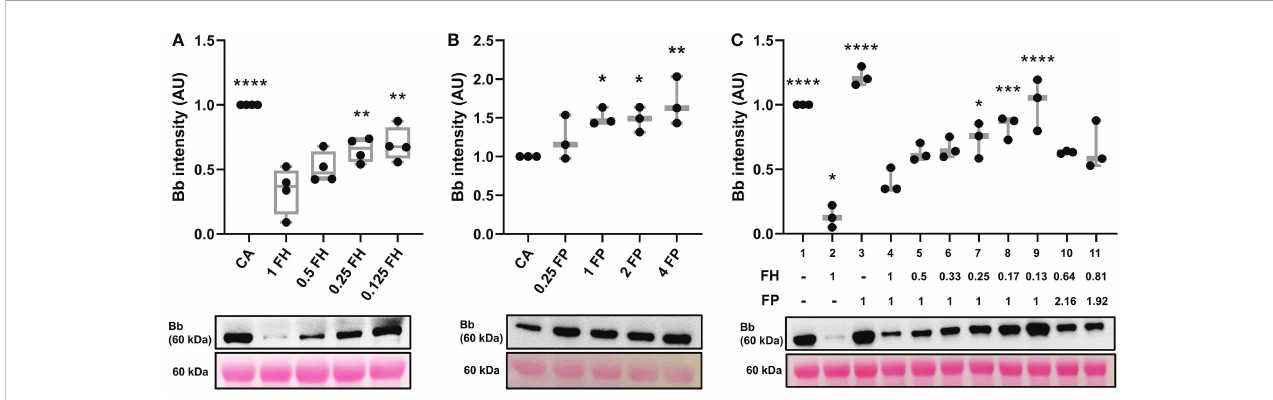
FIGURE 4 FH inhibits C3 convertase formation in dose dependent manner. (A) Western blot analysis of C3 convertase formed in presence of varying amounts of FH. Decreasing the concentration of FH (lanes 3-5) leads to decreased inhibition of C3 convertase formation in dose-depended manner, as compared to the normal physiological concentration of FH (lane 2). Box plots show median, 1 st and 3 rd quartile ranges, and the individual data points of four independent experiments. (B) Western blot analysis of C3 convertase formed in presence of varying amounts of properdin. Increasing the concentration of FP (lanes 3-5) leads to increased formation of C3 convertase in dose-depended manner, as compared to convertase alone (CA, lane 1). (C) Western blot analysis of C3 convertase formed in presence of decreasing FH : FP ratio. Decreasing the ratio of FH : FP (lanes 5-9) leads to decreased FH inhibition of complement formation in dose-dependent manner. Low FH : FP ratios allow for a signi fi cant increase (lanes 7-9) in convertase formation as compared to the physiological FH : FP ratio (lane 4). FH and FP biomarkers of two C3G patients with elevated FP levels from MORL C3G cohort are shown in lanes 10 (FH: 287ug/mL, FP: 43.2 ug/mL) and 11 (FH: 363 ug/mL, FP: 38.4 ug/mL). Results were normalized to CA and presented as relative protein expression. Ponceau S Staining was used as a measure of total protein load. Box plots show median, 1 st and 3 rd quartile ranges, and the individual data points of three independent experiments. Signi fi cance calculated for CA. * P ≤ 0.05, ** P ≤ 0.01, *** P ≤ 0.001, **** P ≤